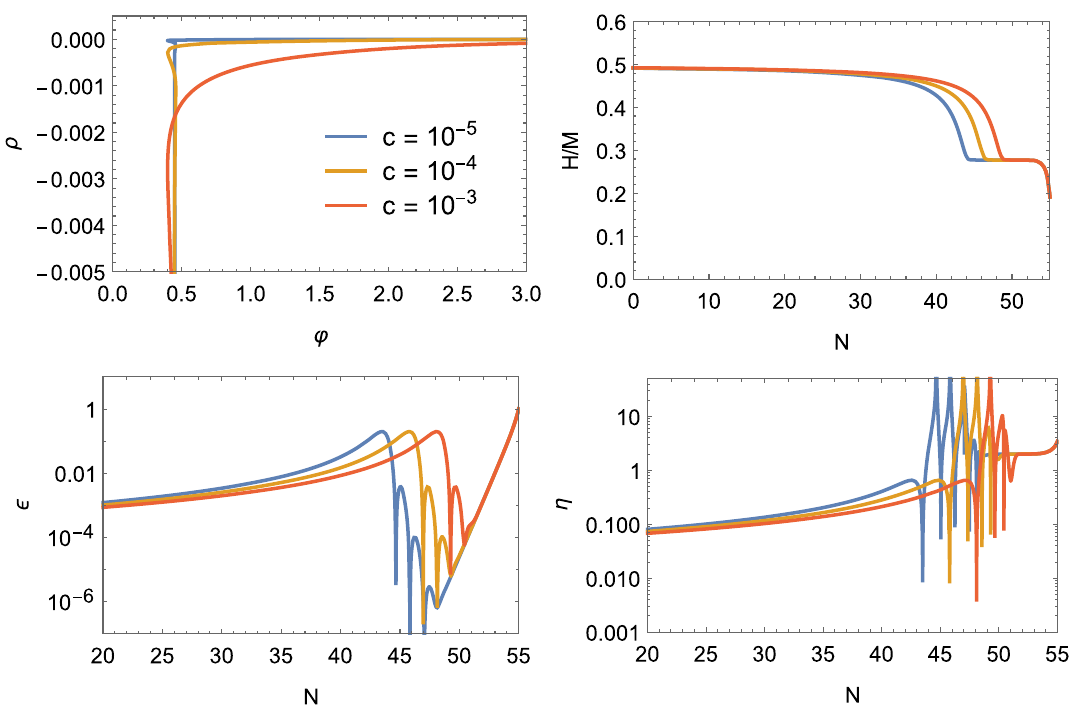
Fig. 3 The solution to Eqs. (21)–(24) with the initial conditions (28) and b = − f = 1.Thetwo-fieldtrajectoryisontheupperleft.TheHub- ble function during the last 55 e-folds is on the upper right. The lower